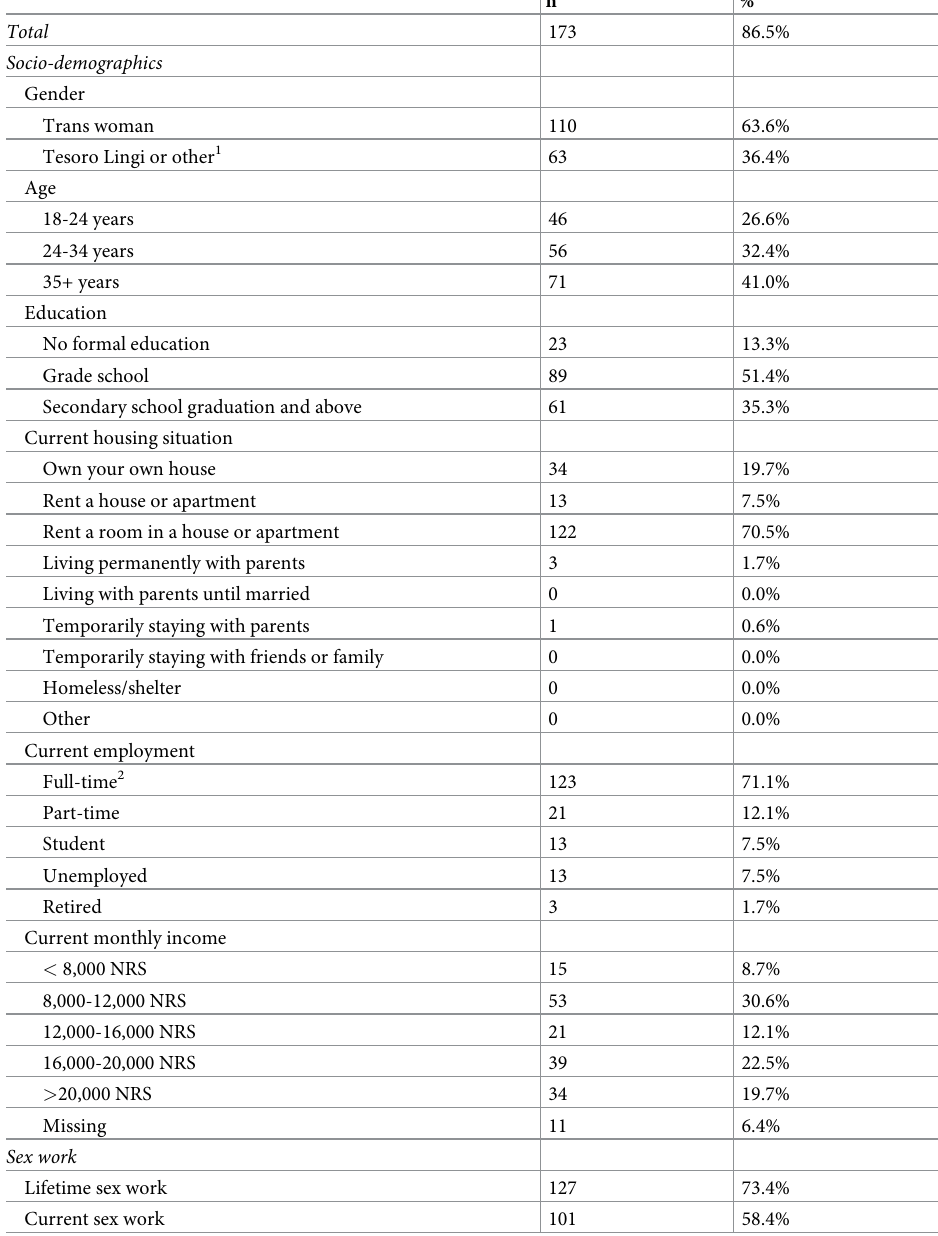
Table 1. Socio-demographic characteristics and sex work status of HIV-negative trans women, Tesoro Lingi, or people with other genders in Nepal, 2019. n % Total 173